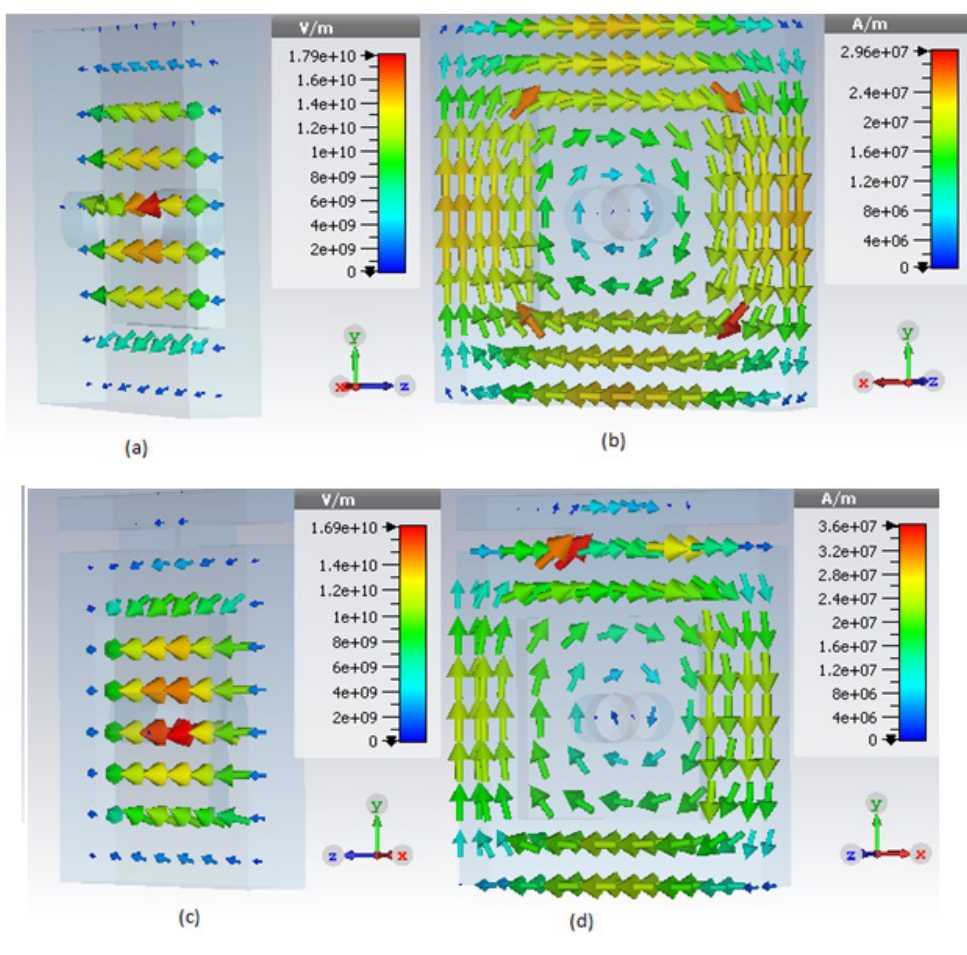
Figure 3. ( a ) Electric field in intermediate RRSC, ( b ) Magnetic field in Intermediate RRSC, ( c ) Electric field in input and output RRSC, and ( d ) Magnetic field in input and output RRSC.